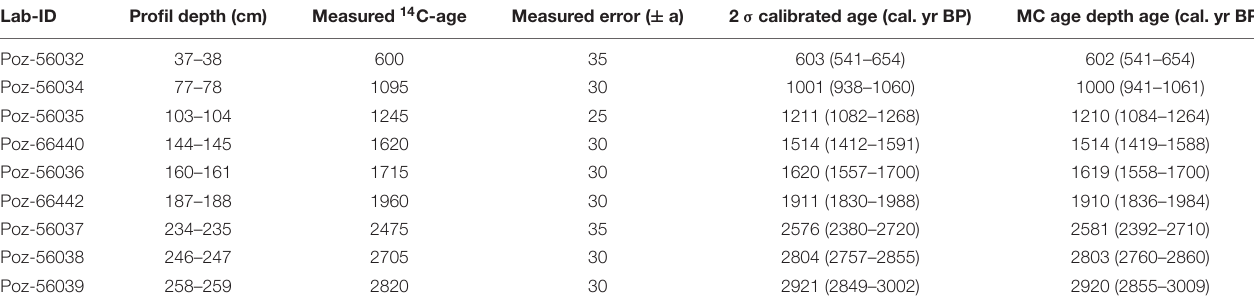
TABLE 1 | Radiocarbon ages of core Tuz-694 from the CTP. Lab-ID